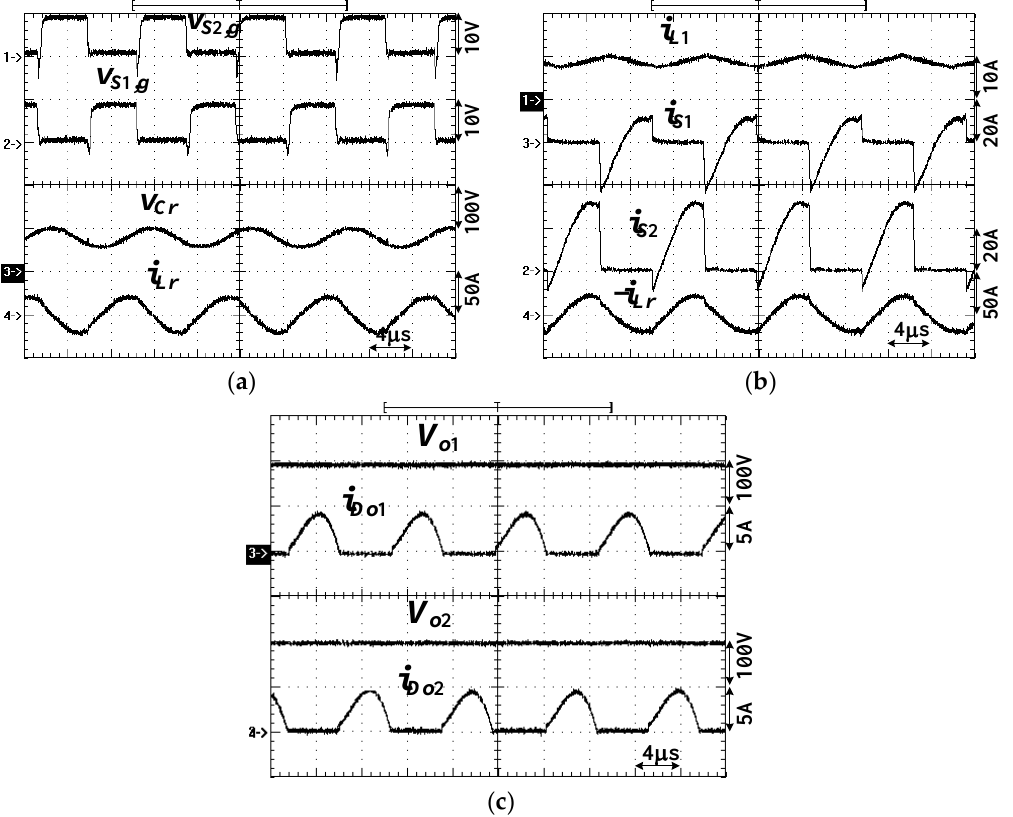
Figure 12. Test waveforms at V in = 80 V and rated power: ( a ) v S 1 , g , v S 2 , g , v Cr , i Lr ; ( b ) i L 1 , i S 1 , i S 2 , − i Cr ; ( c ) i Do 1 , i Do 2 , V o 1 , V o 2 .